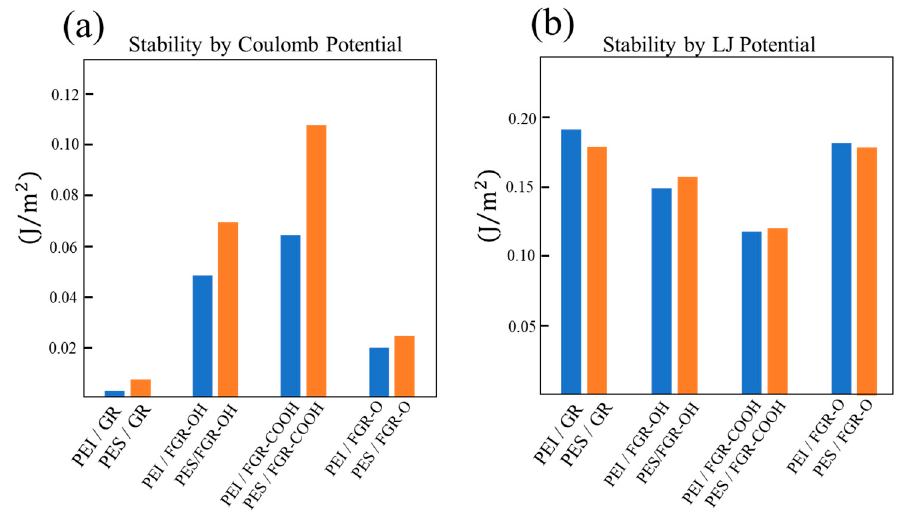
Figure 9. Interfacial stability is based on the ( a ) Coulomb potential and ( b ) Lennard–Jones potential for different composite models. The stability is defined by the absolute values of potential energies.